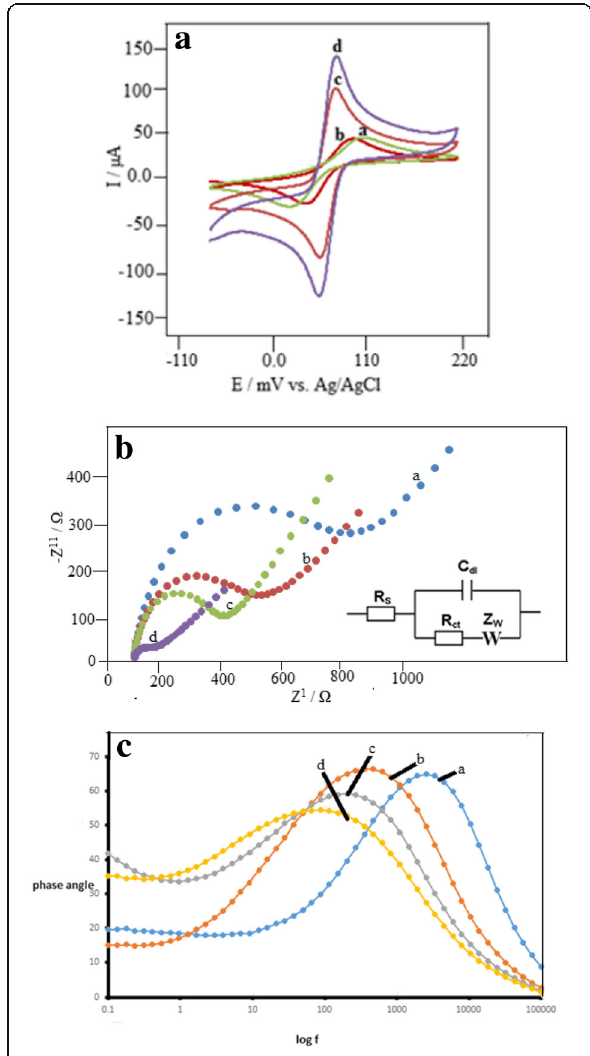
Fig. 3 A CVs of 10mM K 3 [Fe (CN) 6 ] at the bare GCE (curve a), Bi 2 O 3 /GCE (curve b), MWCNT/GCE (curve c), and Bi 2 O 3 /MWCNT/GCE (curve d). B Nyquist plots ( − Z ″ vs. Z ′ ) obtained from impedance measurements in the presence of 10mM [Fe (CN) 6 ] 3 − /4 − (1:1) and 0.1M KCl solution for bare GCE (curve a), Bi 2 O 3 /GCE (curve b), MWCNT/GCE (curve c), and Bi